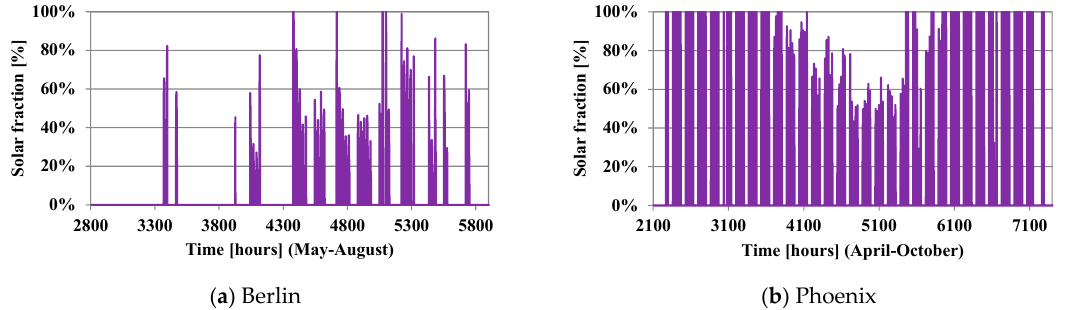
Figure 20. Variation of instantaneous solar fraction without storage.